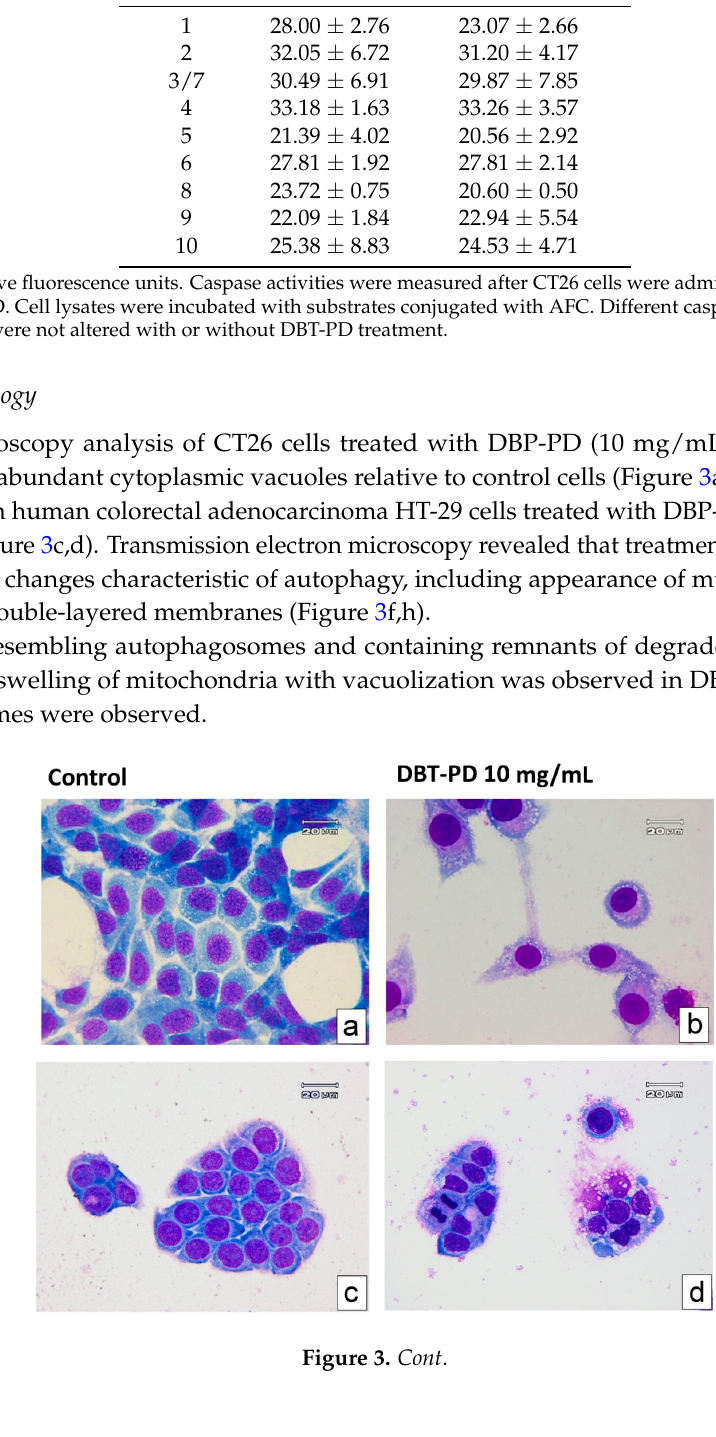
Figure 3. Morphology changes in CT26 cells. Left panels: CT26 cells without treatment Right panels: CT26 cells treated with 10mg/mL DBT-PD for 72h. ( a , b ) CT26 cells; ( c , d ) HT-29 cells were stained with Liu’s stain and photographed under a light microscope; ( e – h ) TEM microphotographs showing the ultrastructure of CT26 cells. Magnification 10,000- and 20,000-fold. 2.7. Enhancement of 5-Fluorouracil (5-FU) Effect by DBT-PD Concurrent treatment of CT26 cells with DBT-PD and low concentrations of 5-fluorouracil (5-FU) markedly inhibited cell growth compared to that with DBT-PD or 5-FU alone (Table 4). It is noteworthy that DBT-PD markedly enhanced the growth inhibitory effect of 0.1 and 0.5 µM 5-FU than that of 1.0 µM 5-FU alone. The combination indices (CI) were calculated using CompuSyn